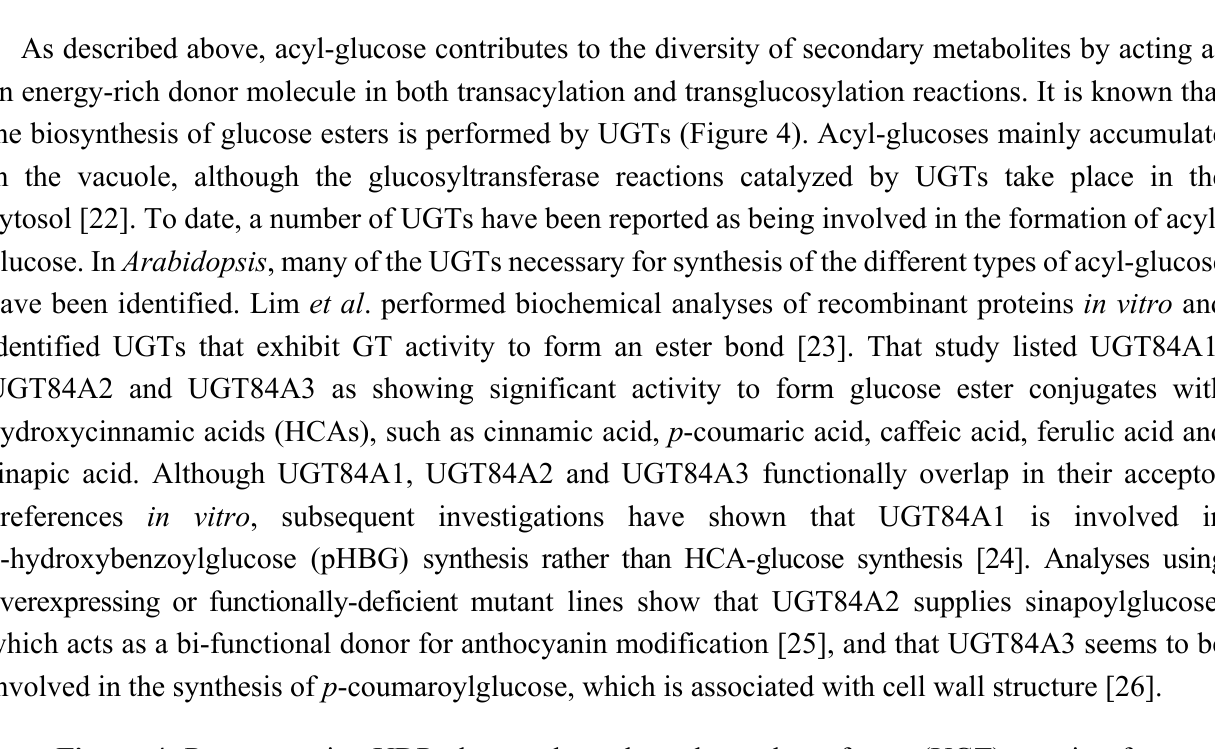
Figure 4. Representative UDP-glucose dependent glucosyltransferase (UGT) reaction for acyl-glucose